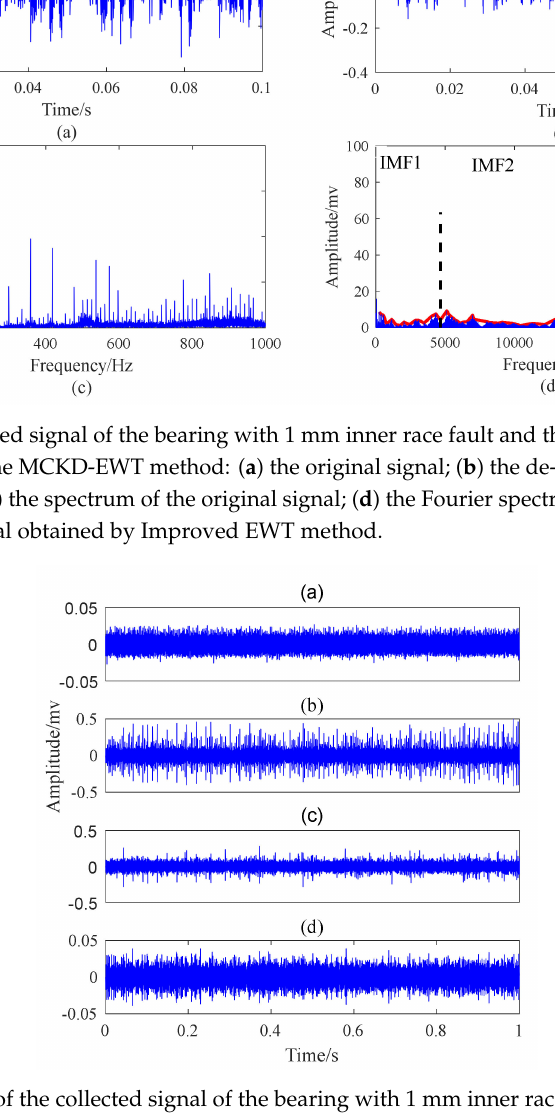
Figure 32. The IMFs of the collected signal of the bearing with 1 mm inner race fault processed by the Improved EWT method: ( a ) IMF1; ( b ) IMF2; ( c ) IMF3; ( d )